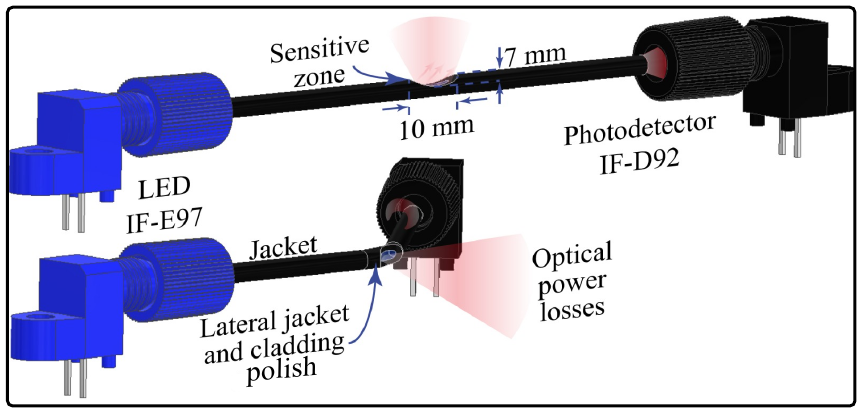
Figure 1. Working principle: side-polished angle